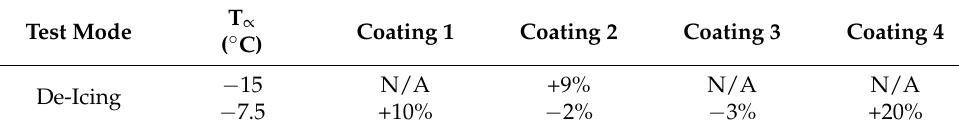
Table 5. De-icing power reduction compared to aluminum due to presence of